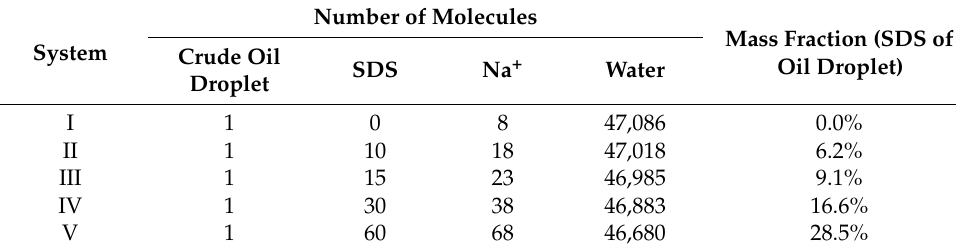
Table 1. Details of the emulsified oil droplet systems.